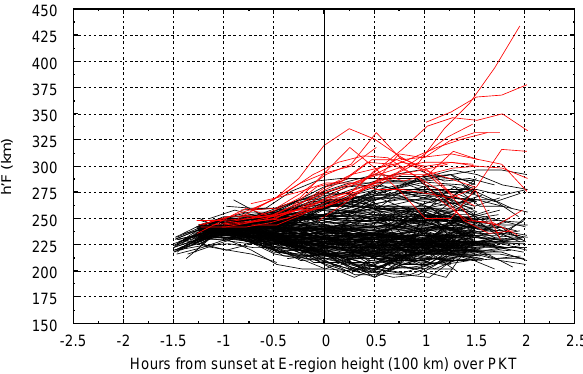
Hours from sunset at E-region height (100 km) over PKT Fig. 1. h 0 F variations at CPN during the local-time period from 18:00 to 21:00THA. It should be noted that the horizontal axis is hours from sunset at E-region height (100km) over PKT. The red lines indicate h 0 F variations on certain days when the peak of h 0 F exceeds 300km.